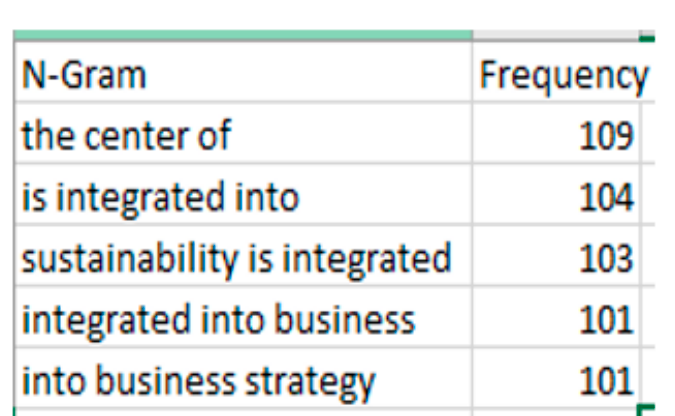
Figure 10. Trigrams.